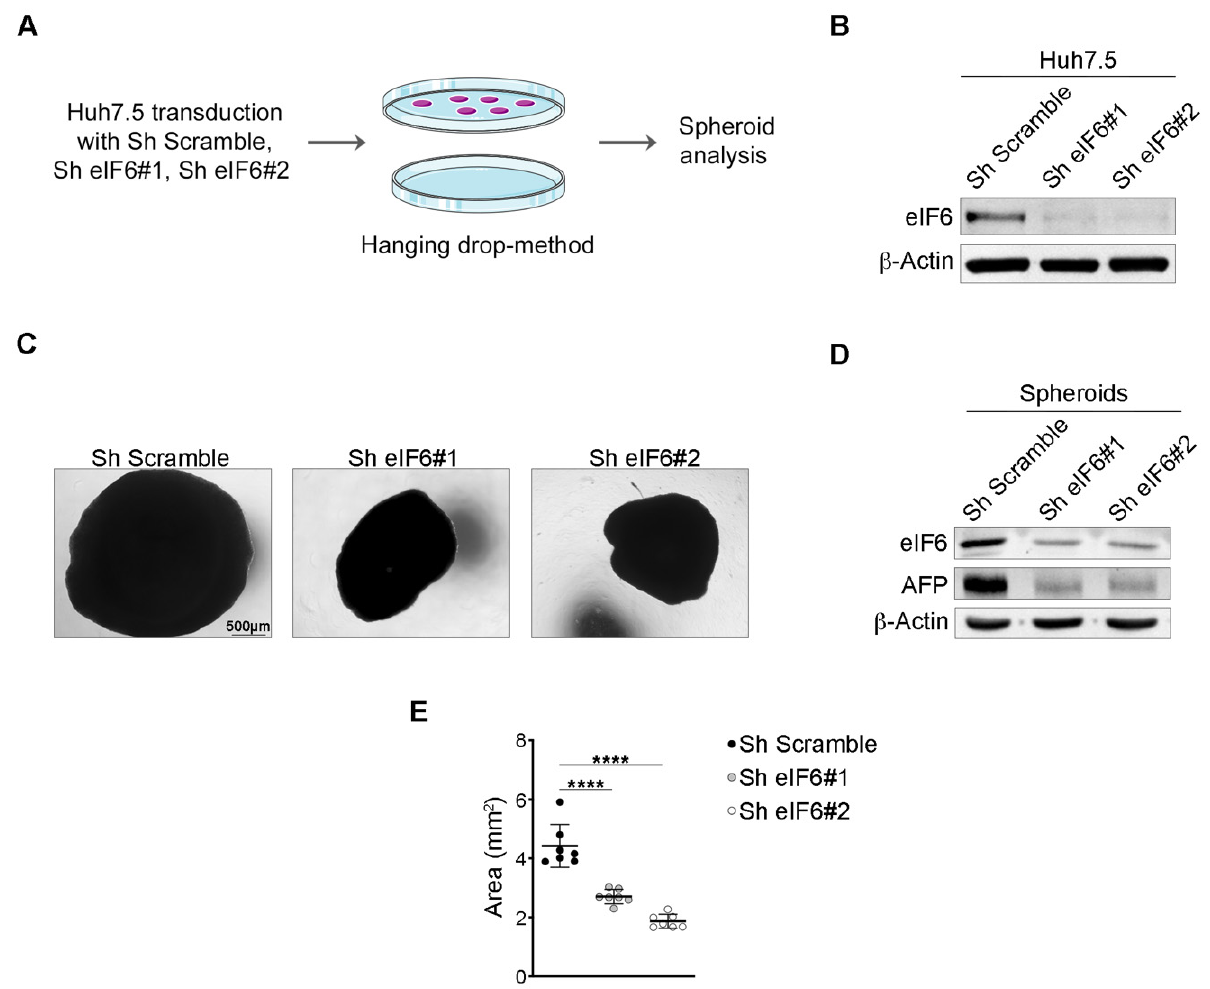
Figure 4. eIF6 depletion impairs HCC spheroid formation. ( A ) Outline of in vitro generation of a 3D- tumor model. ( B ) Representative Western blotting of eIF6 protein levels in Huh7.5 cells transduced with two ShRNA for eIF6 and one control (Sh Scramble). ( C ) Brightfield images of spheroids derived from Huh7.5 cells silenced for eIF6. Sh Scramble-spheroids are used as a control. Scale bar is indicated. ( D ) Representative Western blotting for eIF6 and AFP expression in spheroids. AFP protein levels are reduced in eIF6-silenced spheroids. ( E ) Spheroid area measurement expressed in mm 2 . Bold black lines indicate mean ± SD. Results of two-tailed t tests are shown. **** p value ≤ 0.0001. n = 7 spheroids/condition.